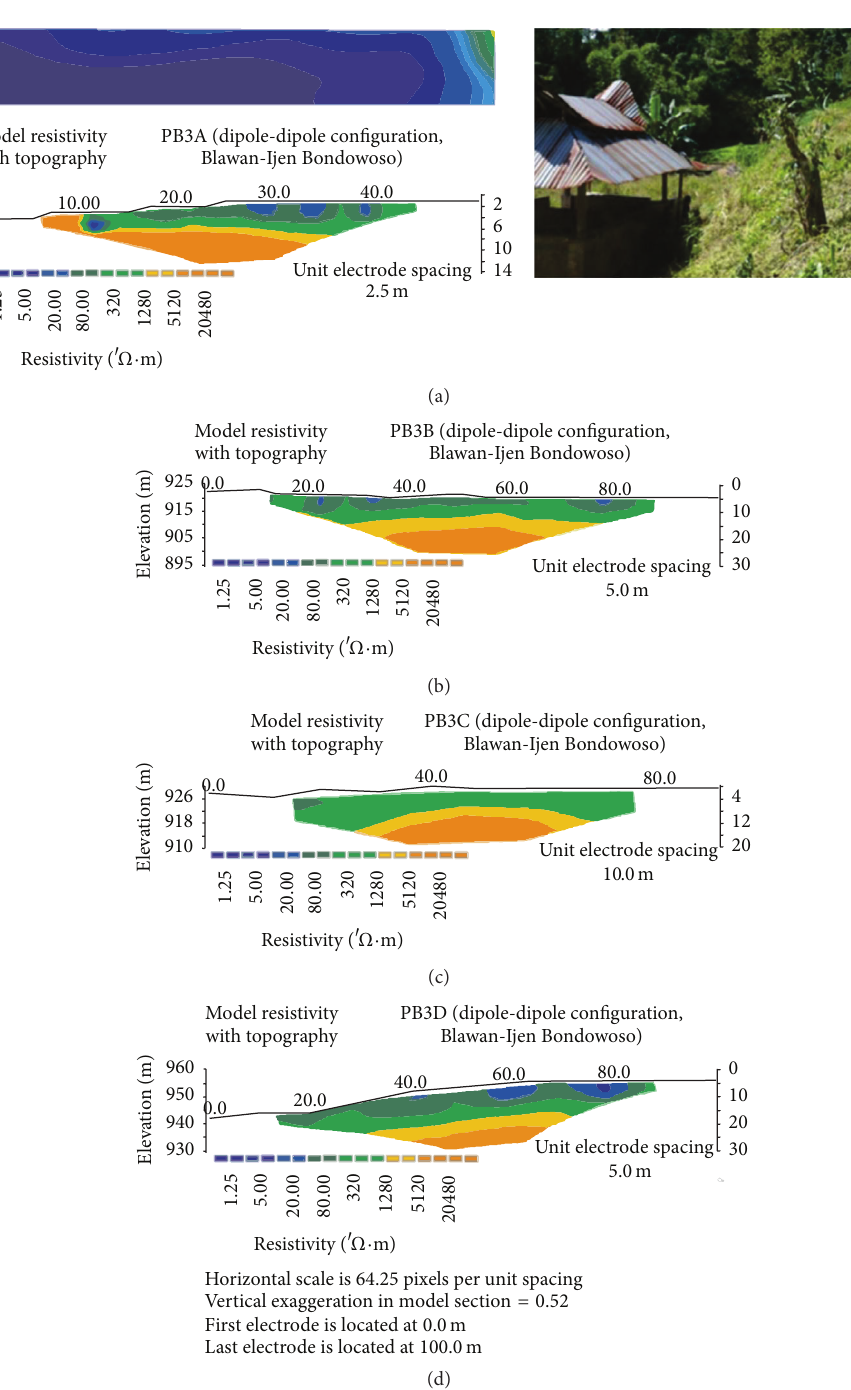
Figure 7: 2D Resistivity Mapping and GPR amplitude slice in locations (a) PB3A, (b) PB3B, (c) PB3C, and (d) PB3D.